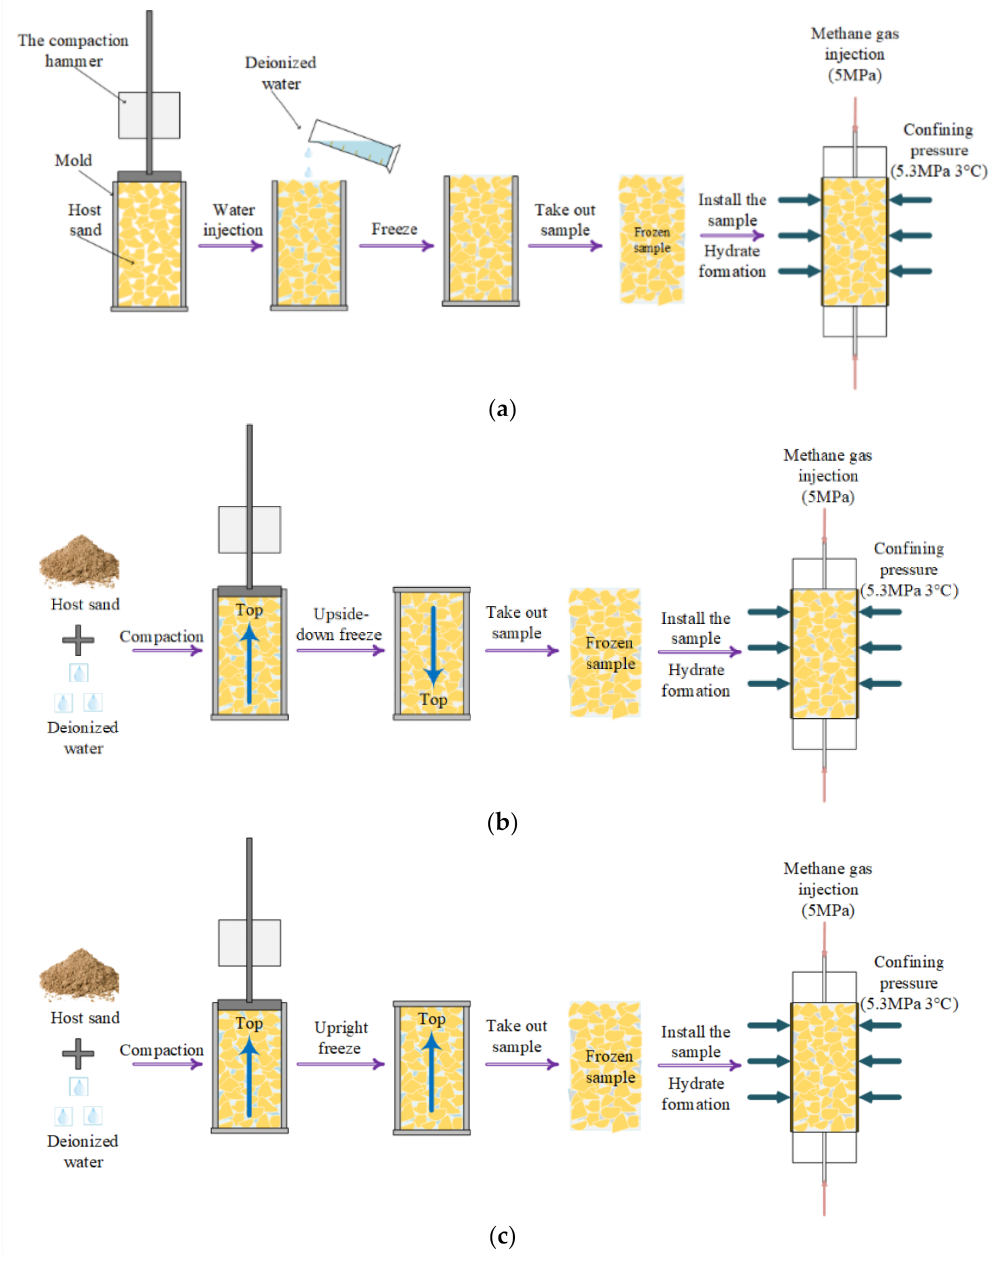
Figure 1. The schematic diagrams of different sand-water mixing methods: ( a ) method 1, ( b ) method 2, ( c ) method